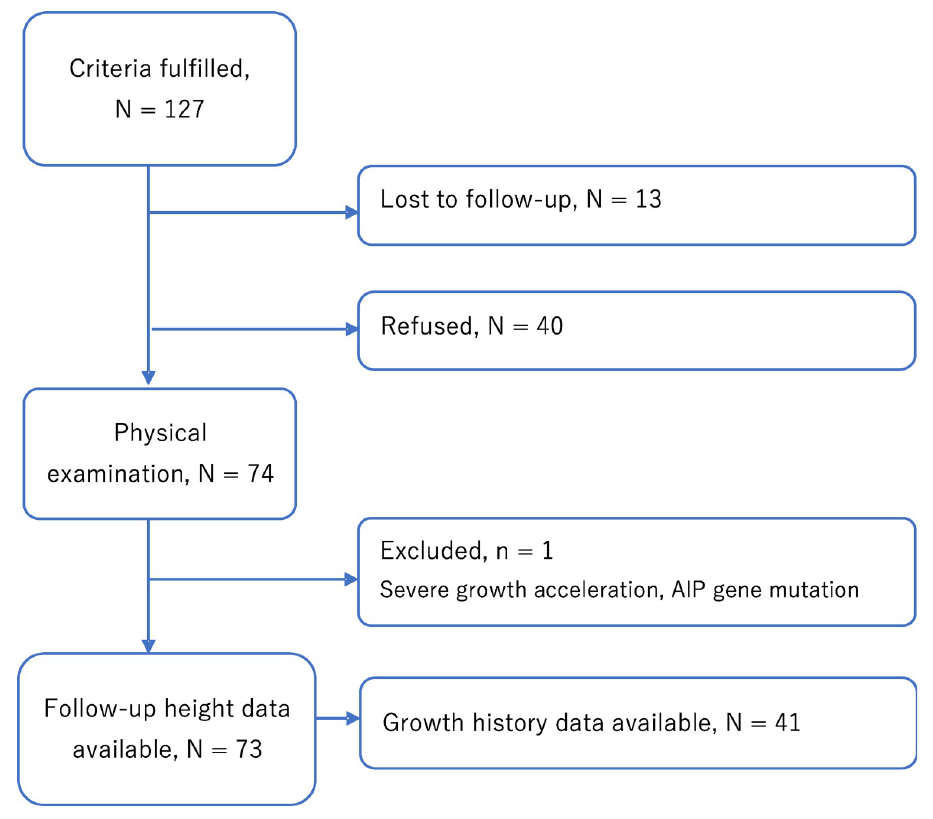
Fig 1. Flowchart of the cohort